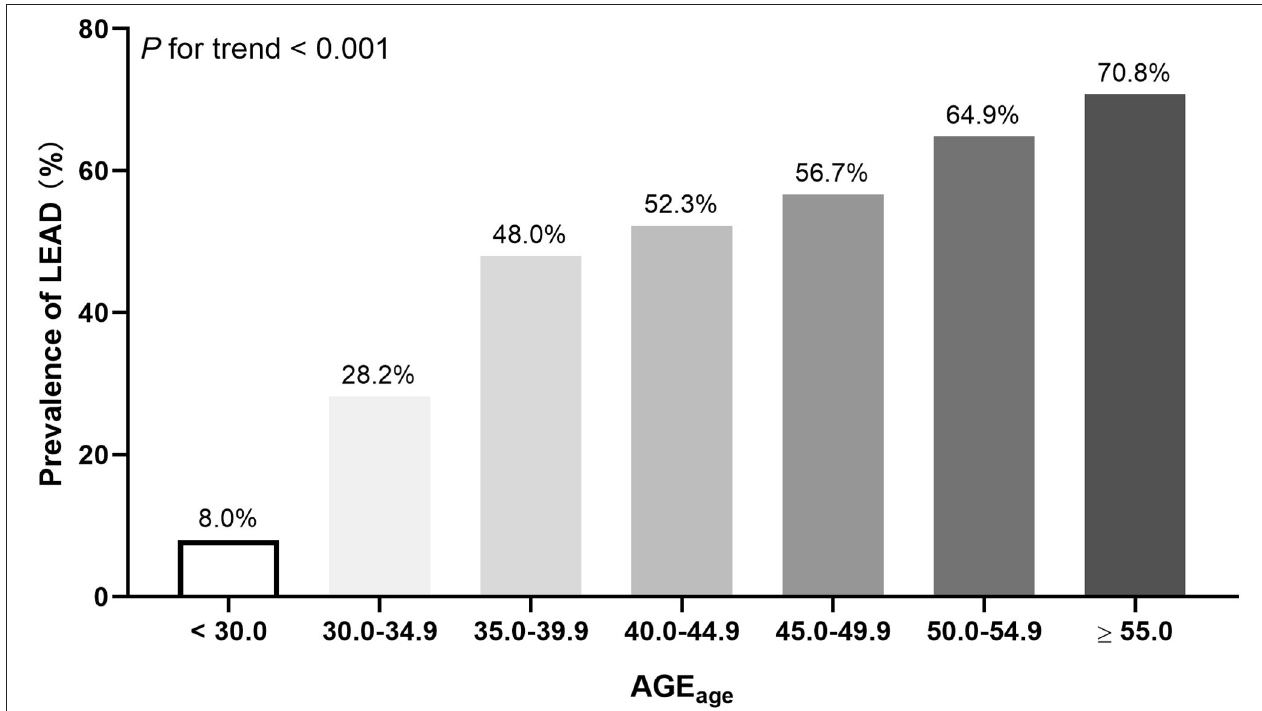
FIGURE 1 | The prevalence of LEAD stratified by AGE age levels.